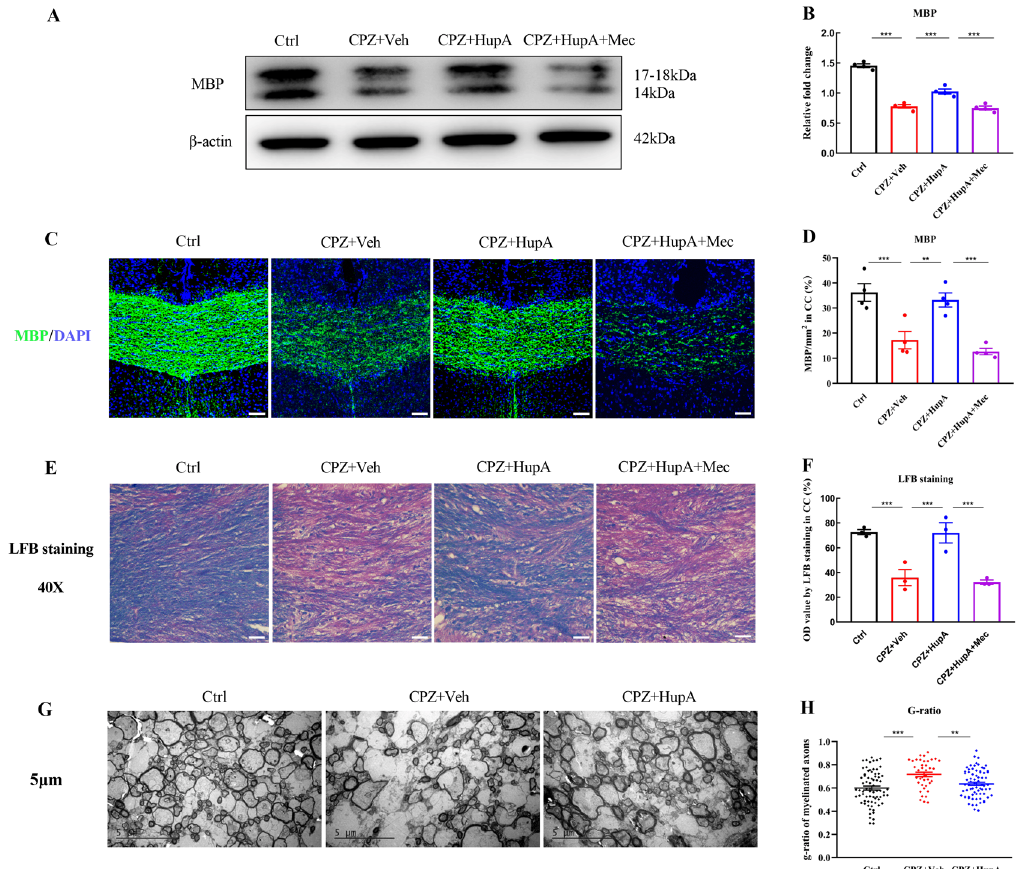
Figure 3. HupA promoted the formation of the new myelin sheath in CPZ-induced demyelination. ( A – F ) Histological evaluation of the demyelination was performed by western blot, MBP, and LFB staining and quantified by Image-J software, scale bar = 50 µ m. Representative images of western blot, LFB, and MBP staining were observed in the corpus callosum of the brain. ( G ) TEM ultrastructure of the corpus callosum (Scale bar = 5 µ m). ( H ) Each group of g-ratio in the corpus callosum. The results represent the mean ± SEM (** p < 0.01, *** p < 0.001, n = 3/4 mice per